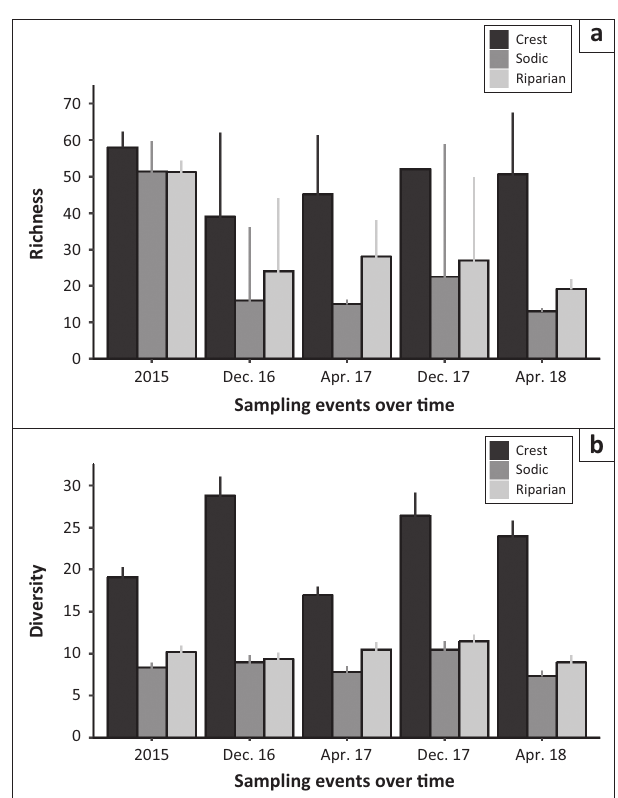
FIGURE 3: Bar chart representing the species richness (Chao estimate) and diversity (Shannon index) for the different sampling seasons at the different topographical units. The height of each column represents the mean, and the error bar represents the upper portion of the 95 % confidence